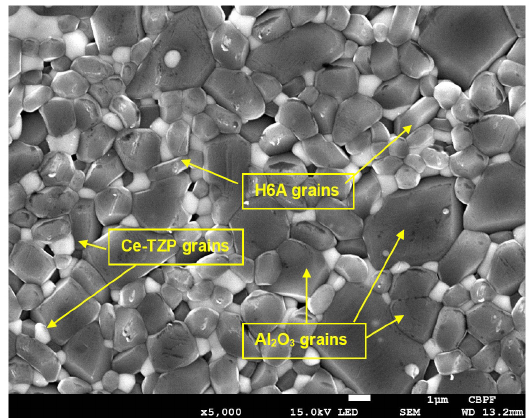
Figure 3. SEM micrograph of sample of Group B observing a matrix with polygonal Al